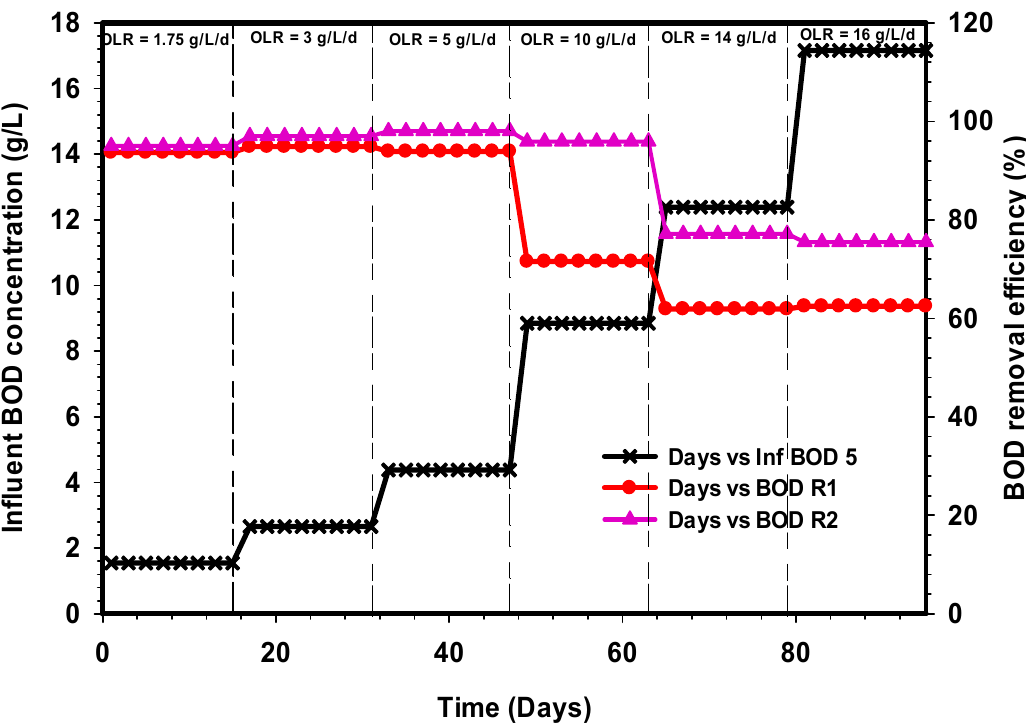
ffi ciencies of R1 and 5 ) removal e